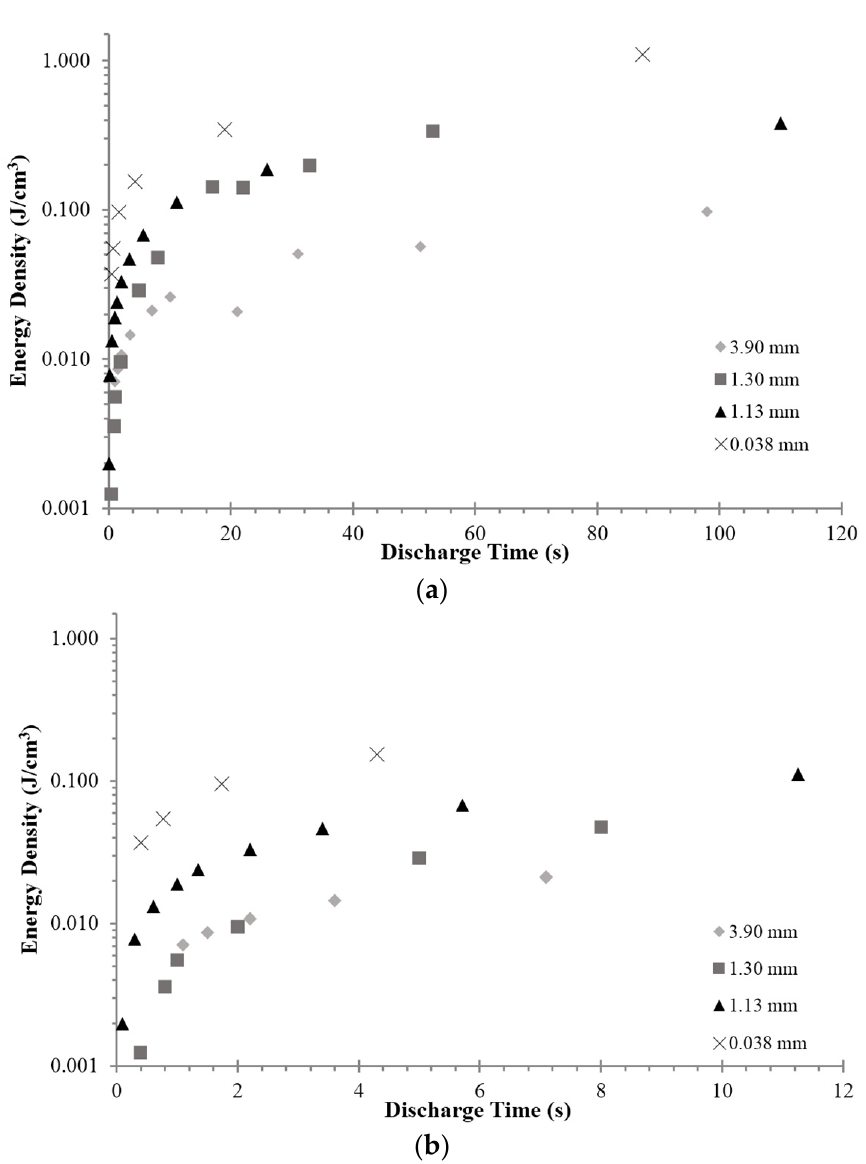
Figure 7. Energy density as a function of DT and dielectric thickness. ( a ) For discharge times up to 120 s. Energy density decreases very slowly for DT > 10 s; ( b ) For discharge times less than 12 s. This clearly shows energy density drops sharply for DT < 2 s.